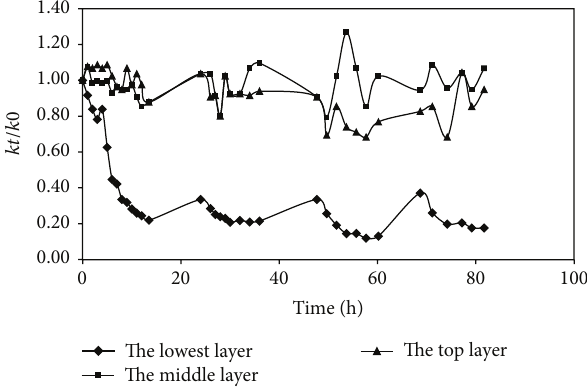
Figure 9: Relationship between 𝑘𝑡/𝑘0 and time in different layers under the hydraulic gradient of 0.625 (experiment